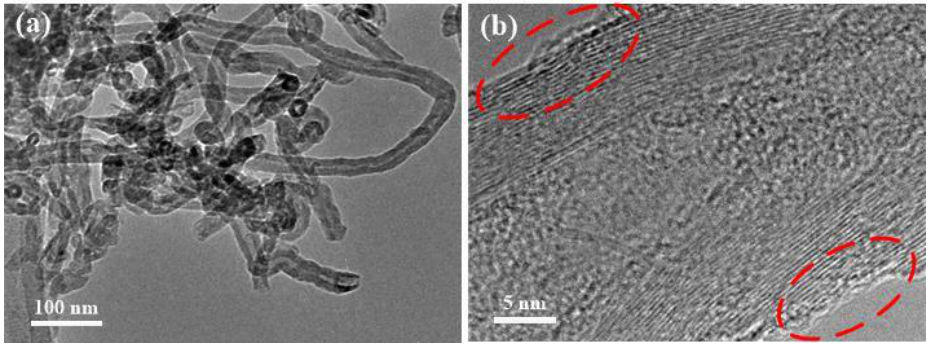
Figure 3. TEM image of MWCNTs-APTES ( a ) low-magnification microscope and ( b ) high-magnification microscope.